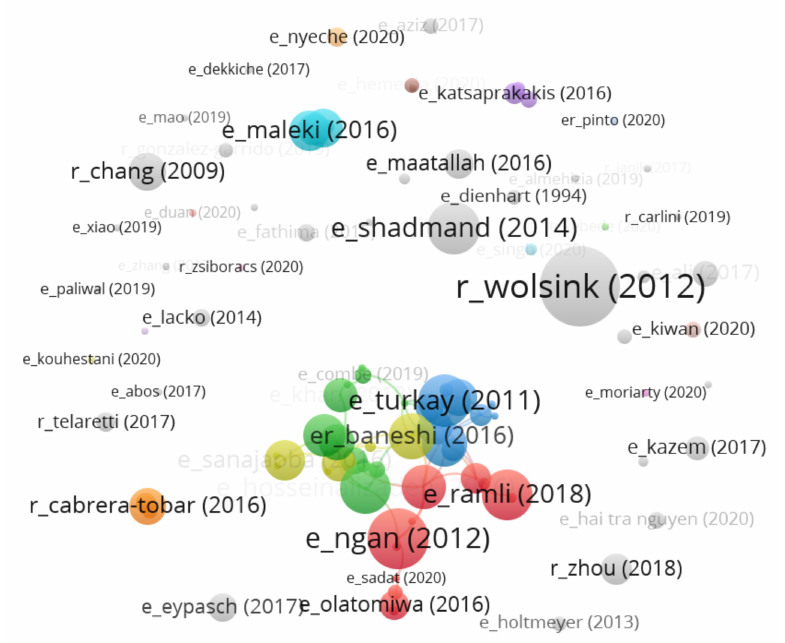
Figure 6. Citation map with all publications in the final sample.